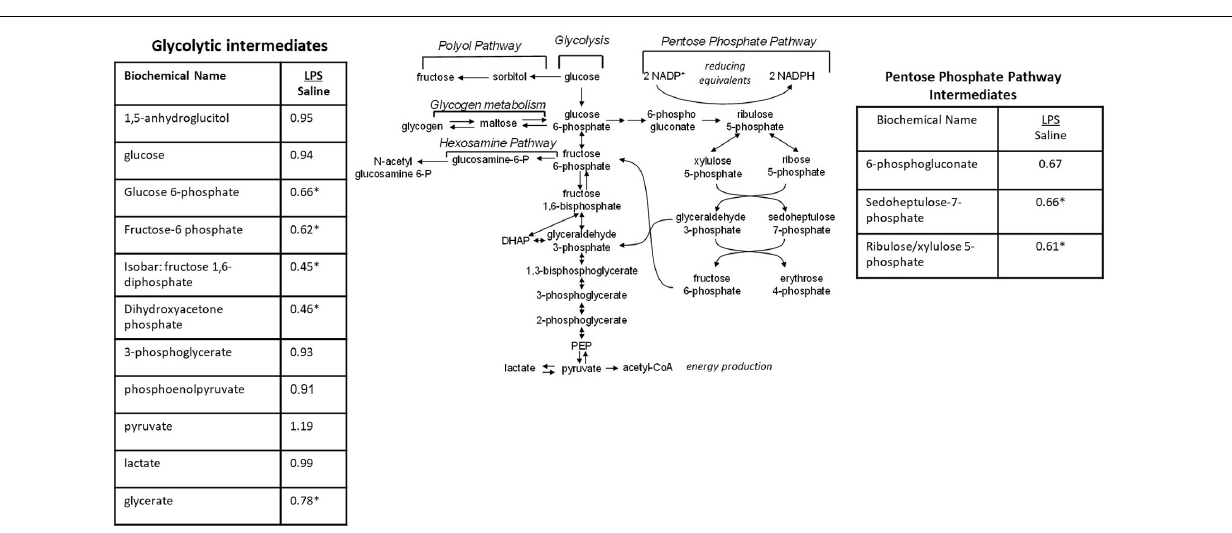
FIGURE 5 | Alterations in Glucose Utilization in LPS Placenta. Relative values of differentially expressed metabolites in LPS placenta expressed as fold change of controls. ∗ Significantly different between LPS and control placenta, p ≤ 0.05 and q ≤ 0.05. N = 8 both